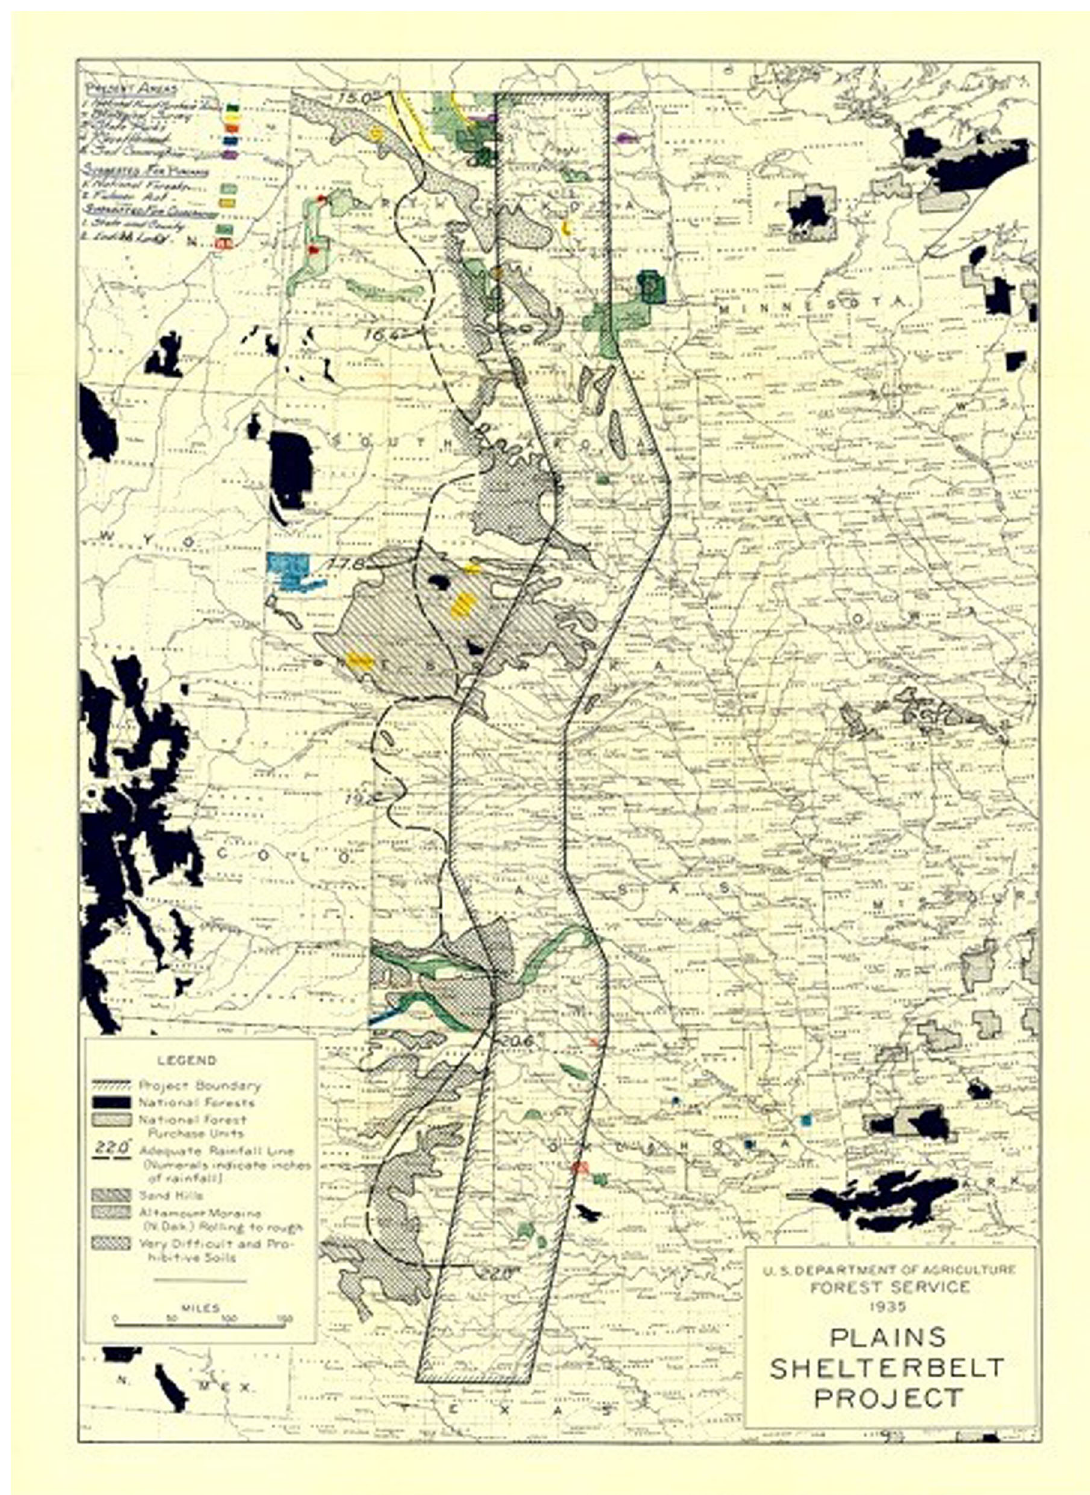
Fig. 2 Final published shelterbelt zone. February, 1935. Originally published in Possibilities of Shelterbelt Planting in the Plains Region . (Source: the Forest Service,